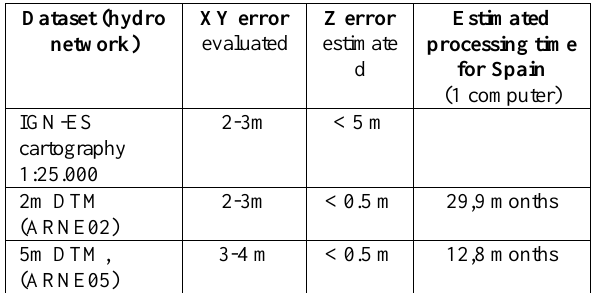
Table 1. Results from viability